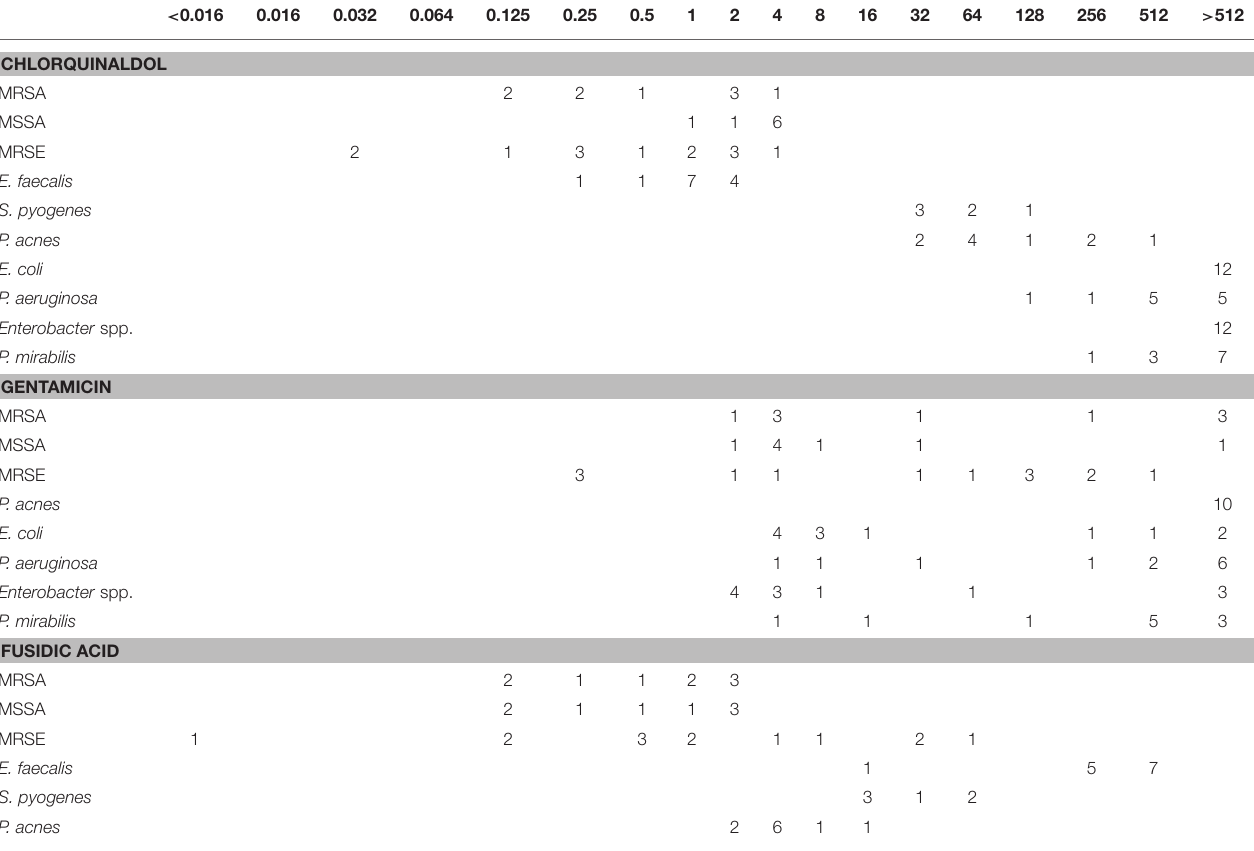
TABLE 4 | MBC distributions